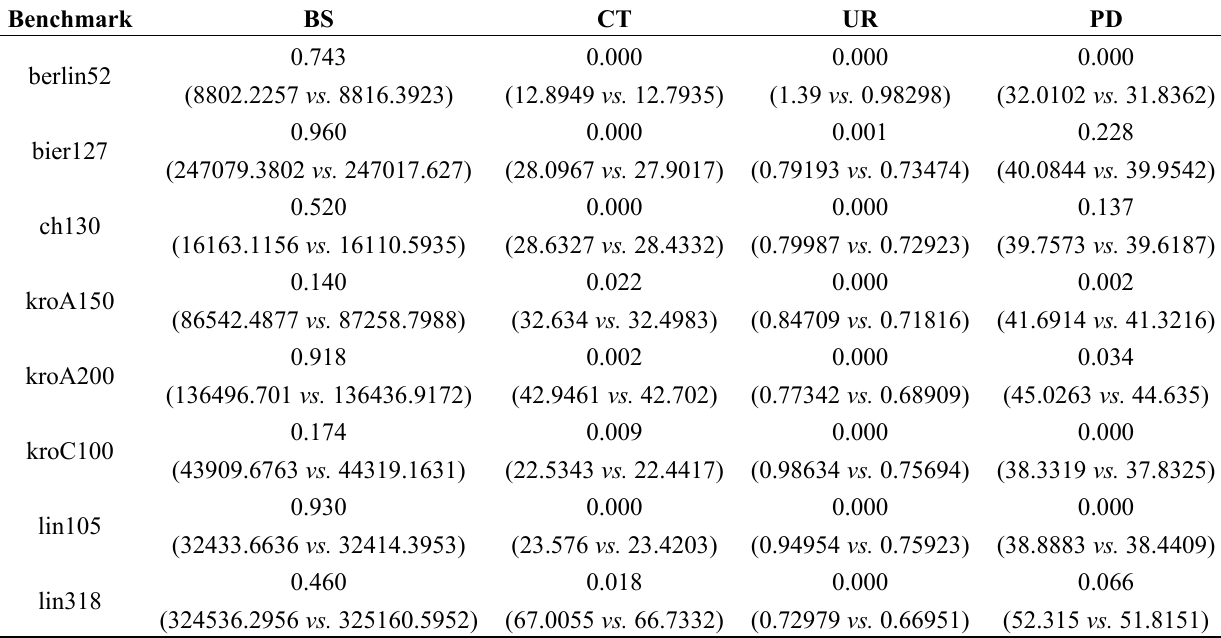
Table 3. Performance comparison of COOBBO and